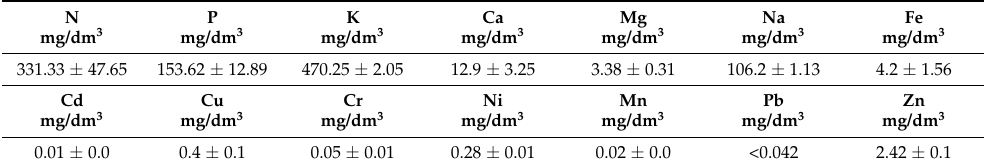
Table 12. Quality composition of liquid phase of digest for lettuce fertilization